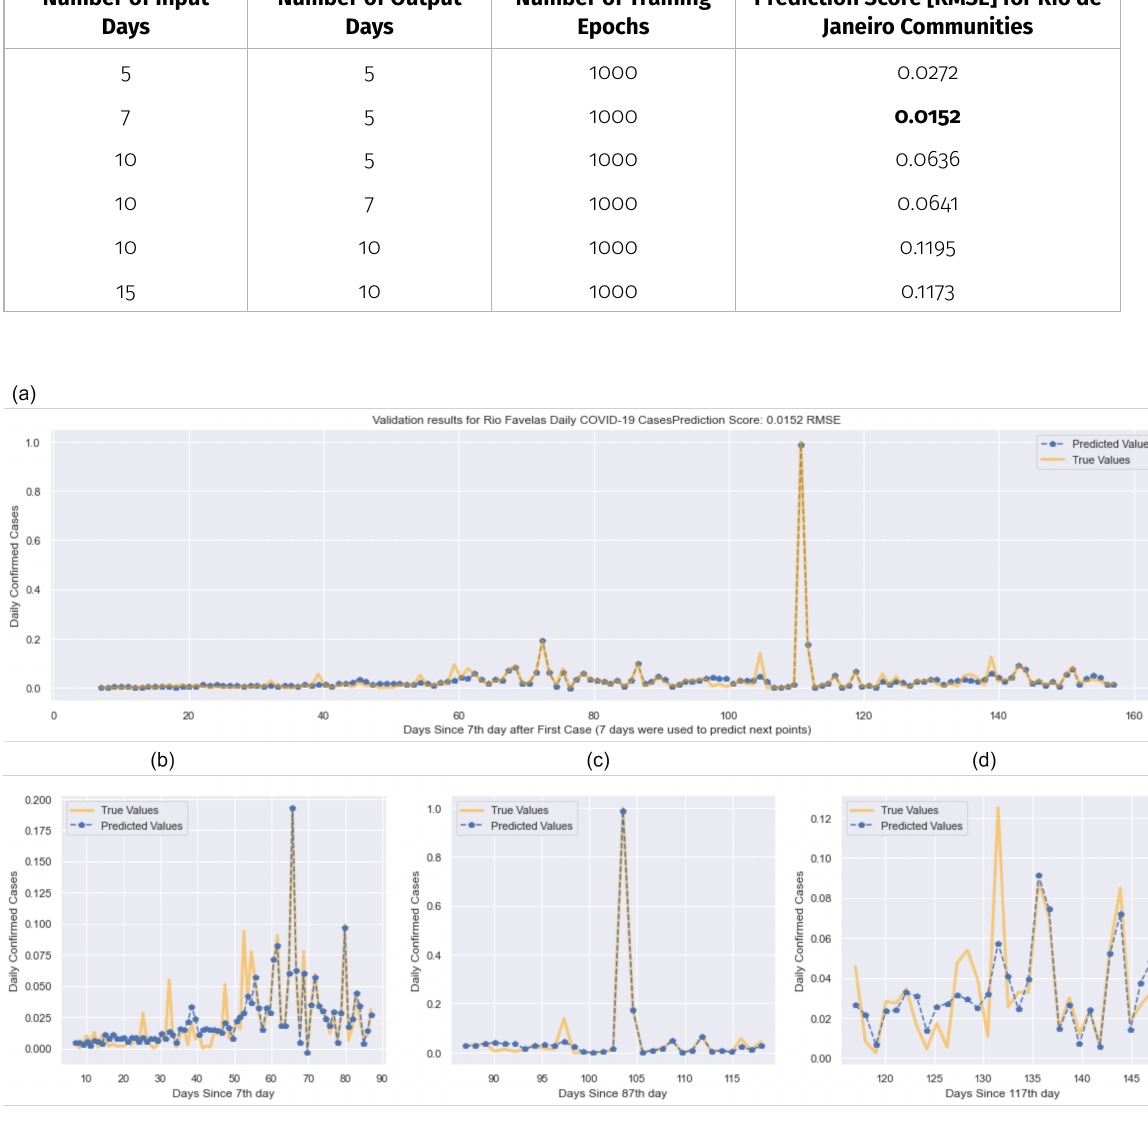
Figure 19. Validation results for Daily cases predictions in Rio de Janeiro favelas. The validation results show that the model can predict the different epidemic scenarios shown in (a,b,c, and d) in cities and